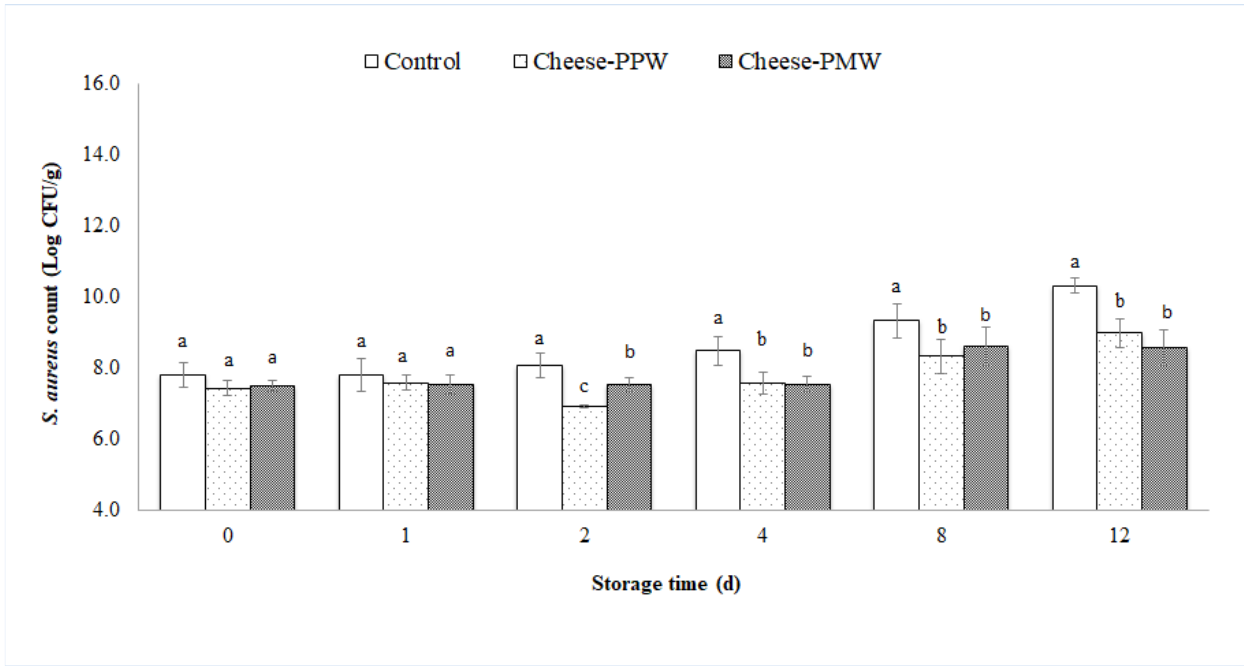
Figure 2. Growth of S. aureus , evaluated up to 12 days of storage at 4 ± 1 °C on cheese supplemented with pomegranate extracts (cheese-PPW and cheese-PMW). Columns at the same storage time (0, 2, 4, and 8 days) followed by different letters are significantly different according to Fisher’s least significant difference test ( p < 0.05). Vertical bars indicate the standard deviation of the mean.